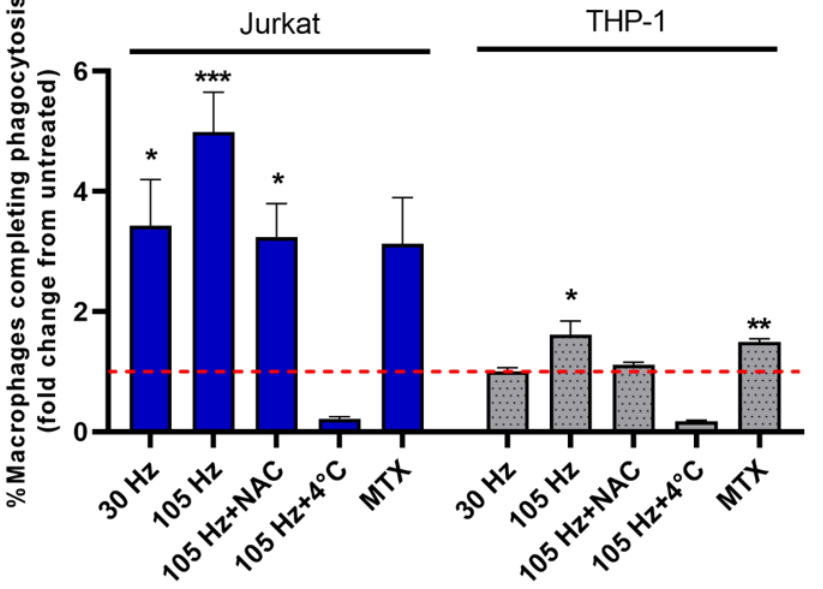
Figure 6. NTP-exposed Jurkat and THP-1 monocytes are phagocytosed by macrophages. Percent- age of THP-1 macrophages completing phagocytosis (WGA+HCST+) of Jurkat or THP-1 cells. Dot- ted line indicates no change with respect to cells in the absence of NTP. Data are presented as mean ± SEM. Significance was calculated using a Kruskal–Wallis test with Dunnett’s post-hoc test (* p < 0.05, ** p < 0.01, *** p < 0.001).